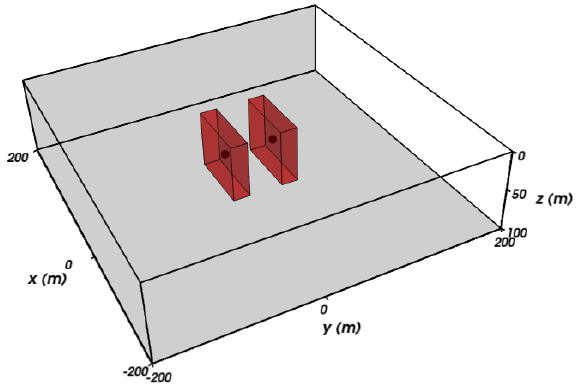
Figure 8. Strongly interfering anomalies. Synthetic prisms (in red) with side lengths equal to 80, 20, and 70m along the x , y and z directions, respectively. Both prisms have a depth of the top at z = 10m. The eastern prism has its centre at xc = 0m, yc = − 30m and zc = 45m, while the western prism has its centre shifted 60m in the positive y direction (pinpointed black